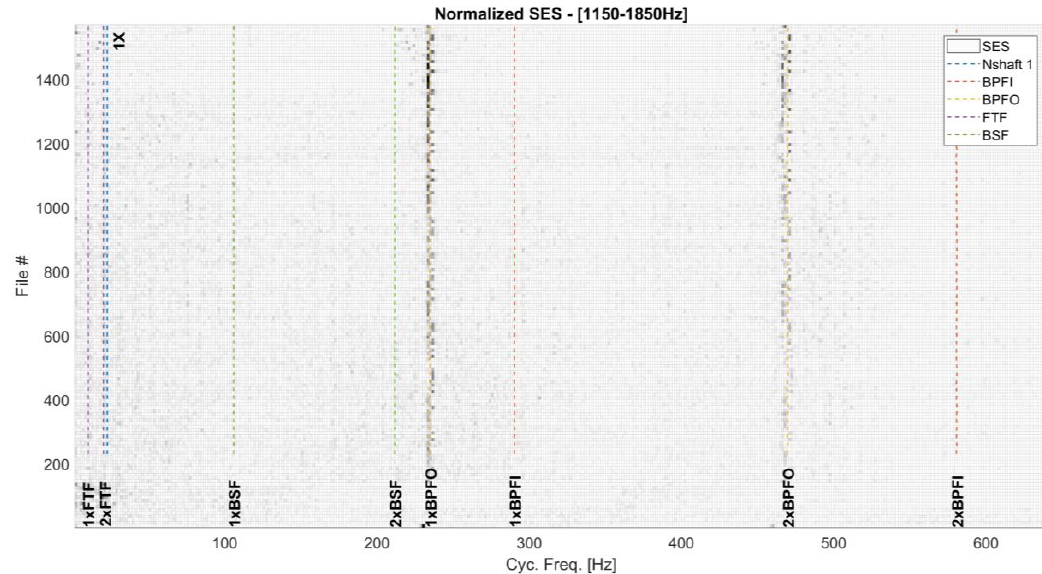
Figure 5. Values of the normalized SES for the different data sets—left TB. The axis on the left of the base plane is relative to the vibration records sorted in chronological order.